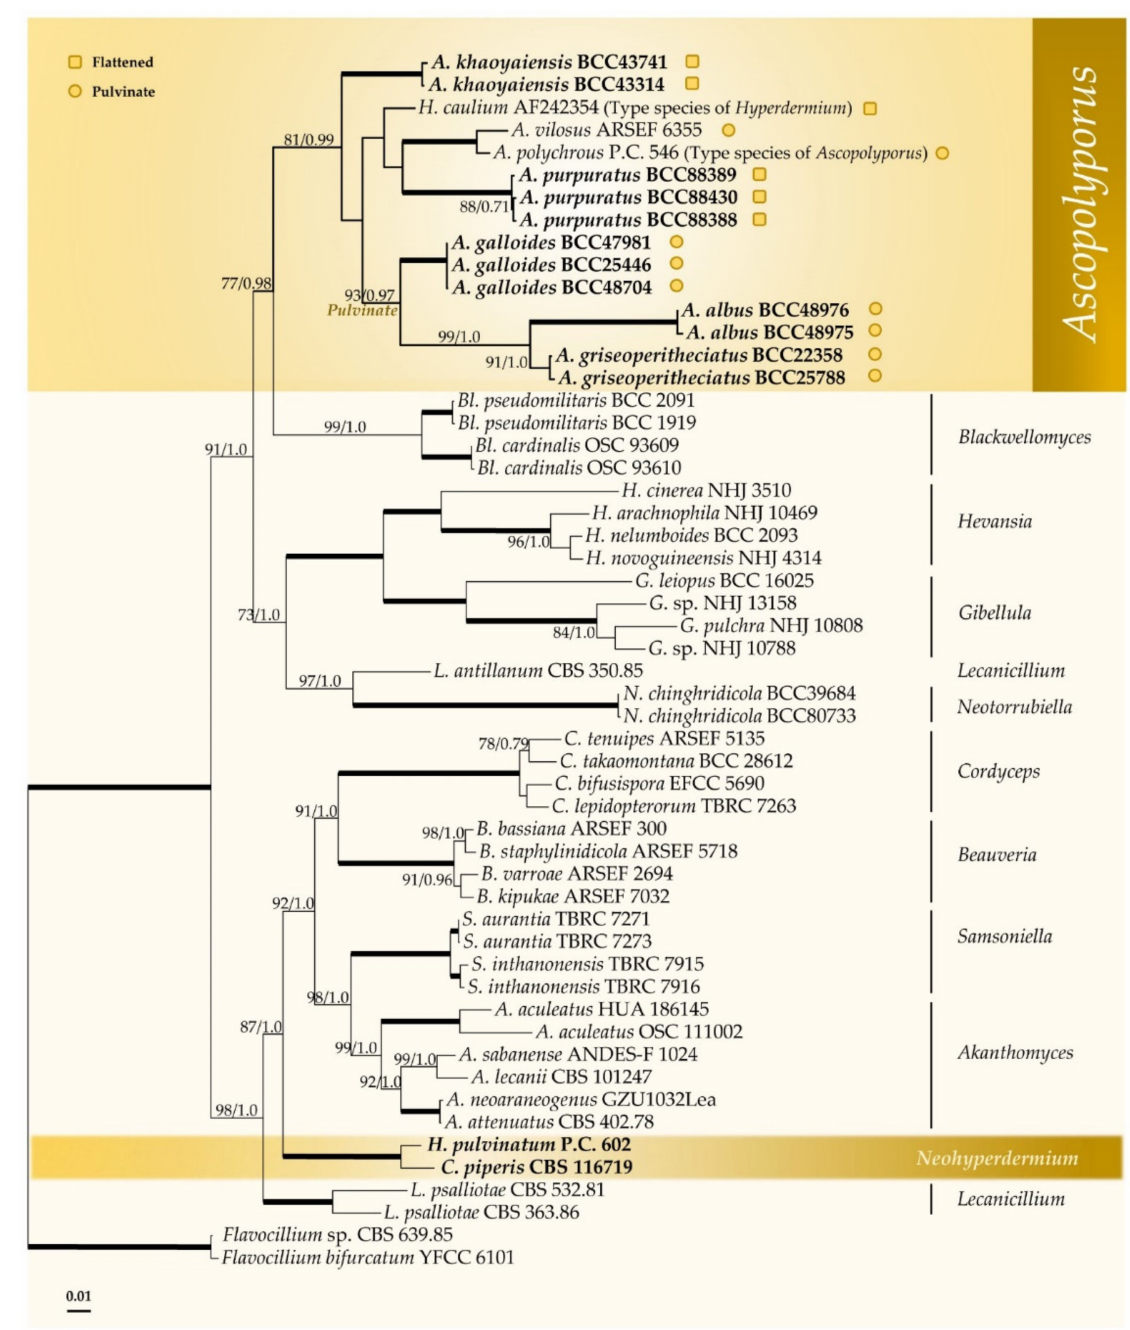
Figure 1. Phylogenetic reconstruction of Ascopolyporus and related genera in the Cordycipitaceae obtained from the combined LSU, TEF1 , RPB1 and RPB2 sequence dataset based on maximum likelihood (RAxML) and Bayesian inference. Numbers on the nodes are ML bootstrap and Bayesian posterior probability values above 70% (MLBS) or 0.7 (BIPP). Thickened lines mean support for the two analyses was 100% (MLBS) or 1.0 (BIPP). represents species with pulvinate stromata while represents species with flattened